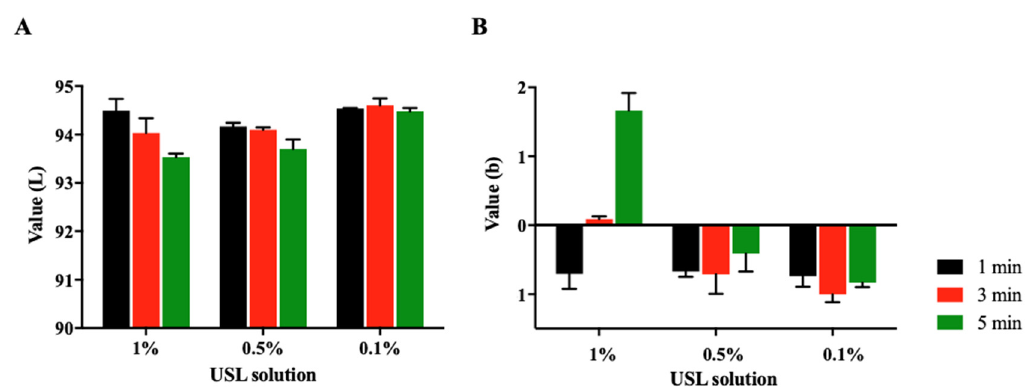
Figure 1. Pigmentation evaluation by measuring the color change on the egg shell membrane according to USL concentration (0.1%, 0.5%, and 1%) and incubation time (1, 3, and 5 min). ( A ) L* value, ( B ) b* value ( n = 3).